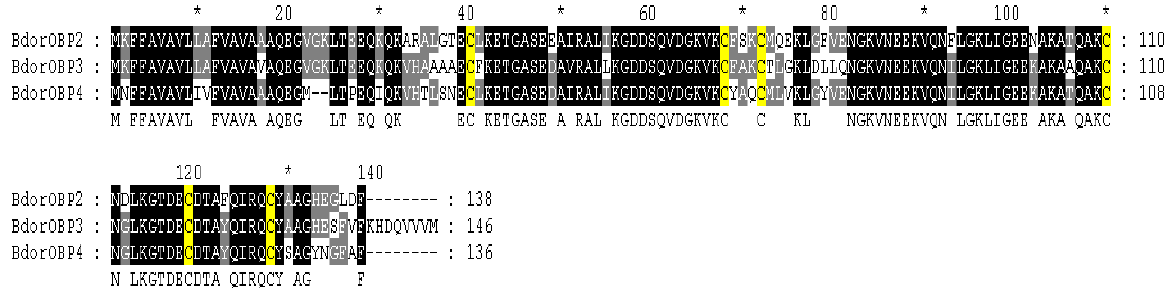
Figure 1. Alignments of the OBP56d group of B. dorsalis odorant-binding proteins (OBPs). Amino acid numbering is provided on the right of the alignment. The numbers above the alignment indicate amino acid position in the alignment. All identical and similar amino acid residues are shaded. Yellow boxes show conserved cysteine residues. The letters below the alignment indicate identical